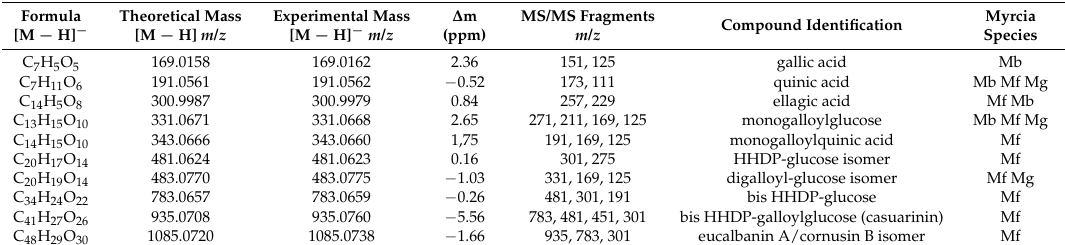
Figure 1. ( A ) ESI( − )-MS of the M. guianensis leaves extract; ( B ) ESI( − )-MS of the M. fallax leaves extract; and ( C ) ESI( − )-MS of the M. bella leaves extract. Table 1. Phenolic acids and hydrolysable tannins identified by ESI( − )-MS from Myrcia spp. leaves